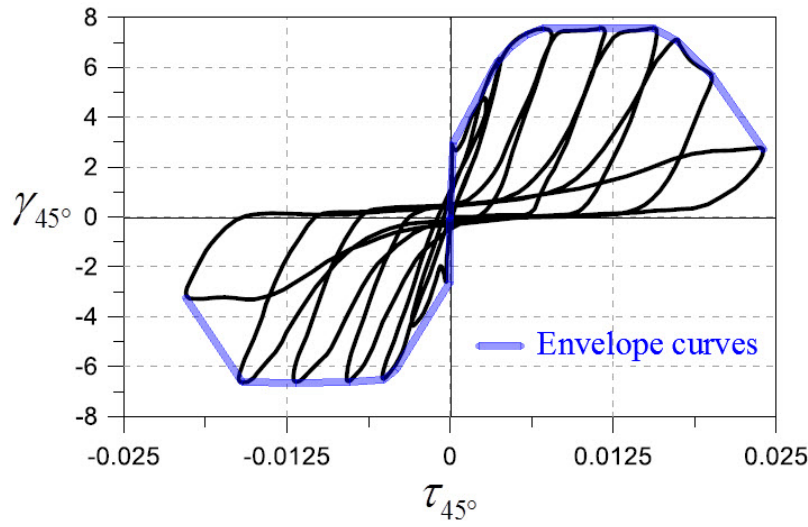
τ γ − curves for the reference RC panels (CD3, CD4, CE2, CE3, CE4 and CF2). ° ° 45 45